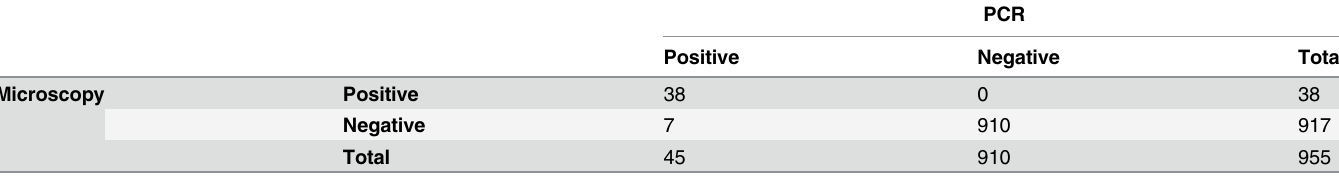
Table 3. Microscopy and PCR results of samples for P . vivax .